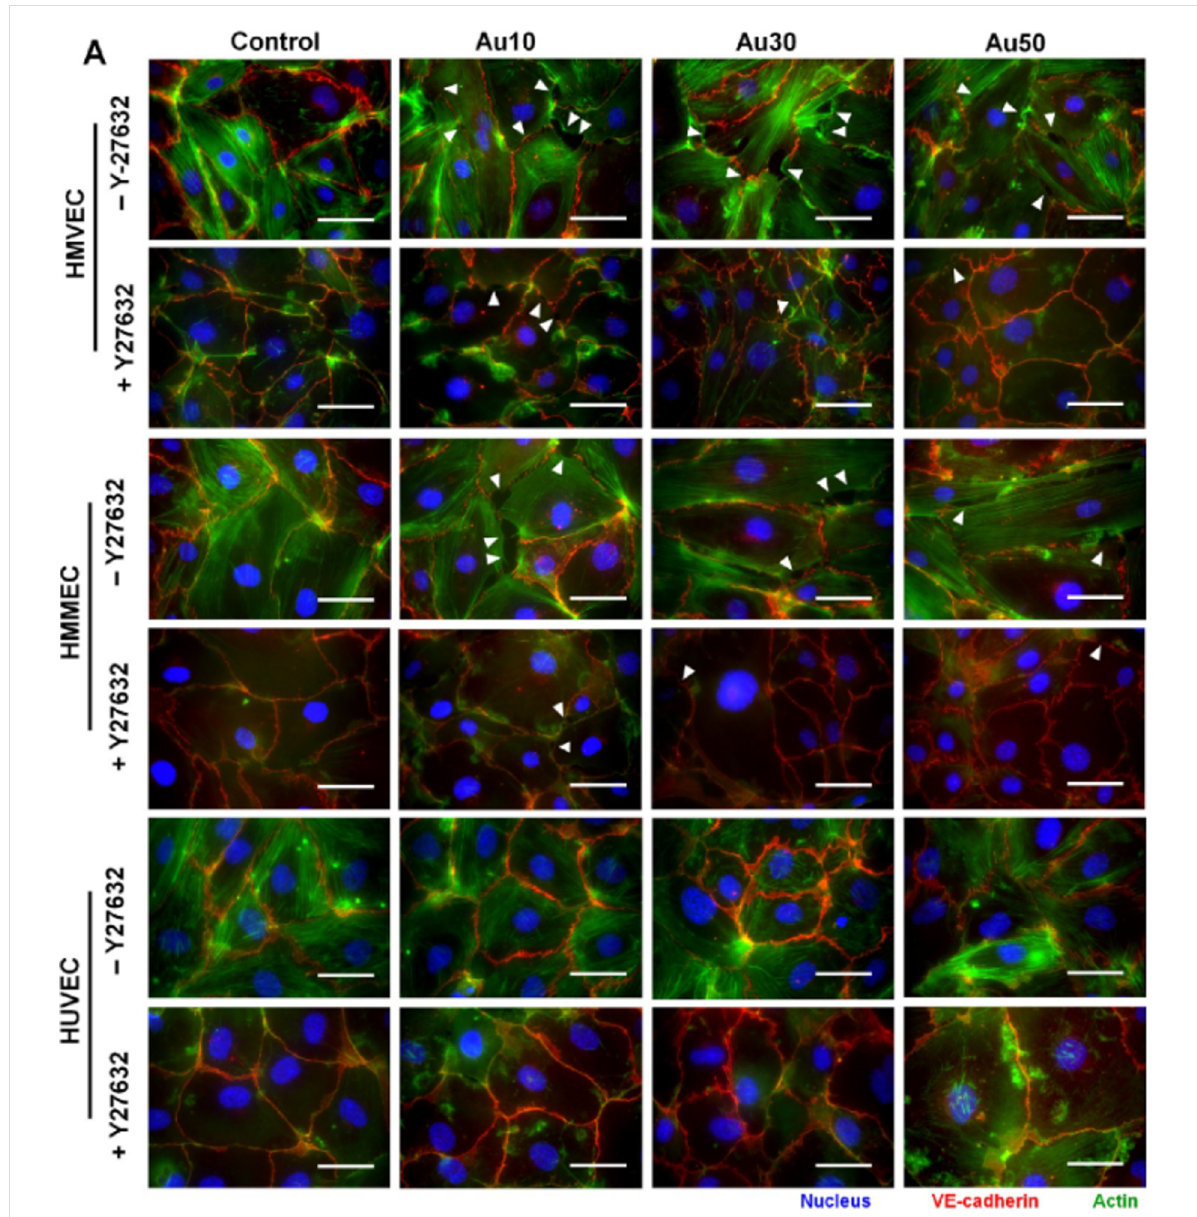
Figure 4: Au NanoEL required actin remodeling. (A) Blocking the RhoA kinase actin remodeling process with Y27632 (10 μ M) significantly reduced the gap formation induced by Au NPs (white arrowheads). Green and blue fluorescent signals represent the VE-cadherin and nucleus, respectively. Scale bar: 50 μ m. Figure 4 was reprinted with permission from [33], Copyright 2017 American Chemical